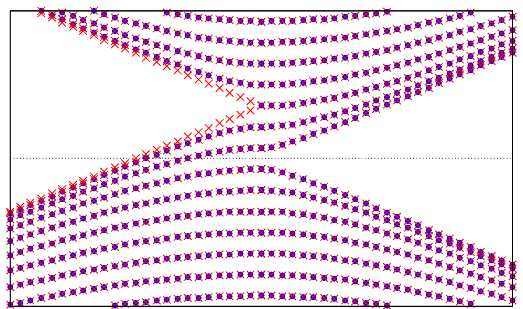
Figure 5 . The spectral flow for the case of ˜ n = 5 . The vertical axis corresponds to the energy, and from the left to the right the deformation of the mass parameter occurs. The stand-alone red crosses indicate non-degenerate energy eigenvalues, whereas the red crosses that are overlaid with blue dots indicate doubly-degenerate energy eigenvalues. The horizontal black dashed line corresponds to the zero energy. We see that the number of zero energy crossings across the spectral flow is indeed equal to ˜ n = 5